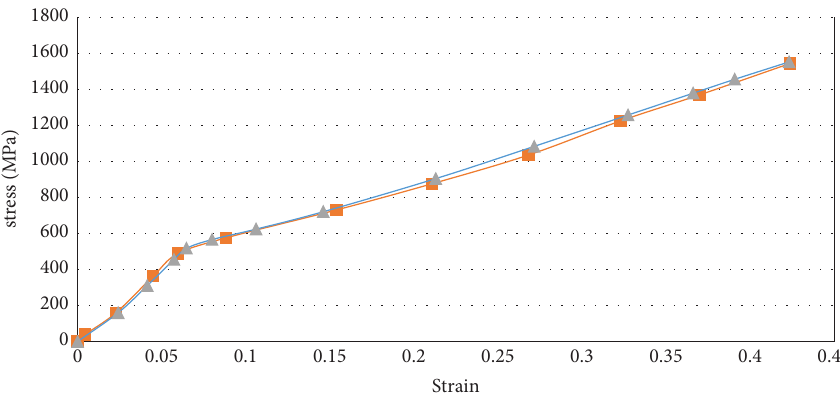
Figure 13: Compressive strength was 1560MPa for the